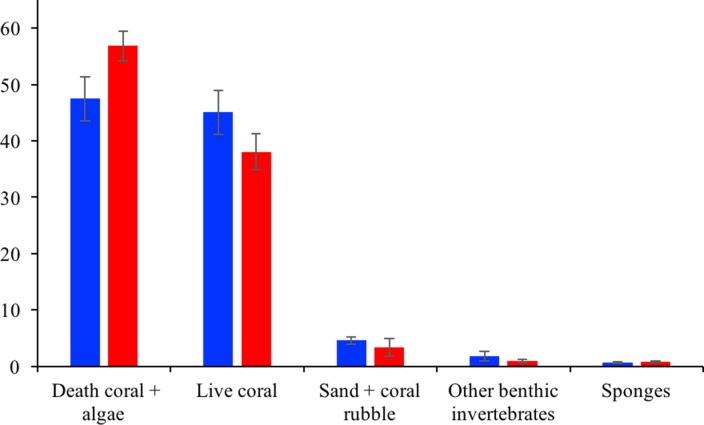
Varadero and Barú benthic cover.Average benthic coverage Varadero (blue) and Barú (red) Reefs. Error bars indicate standard error.